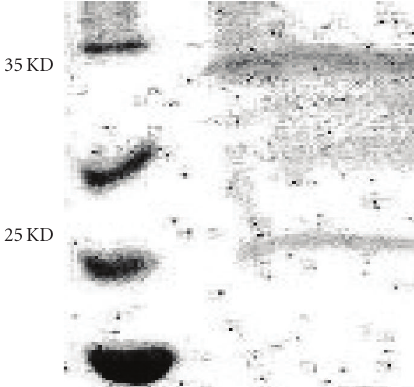
Figure 2: Burkholderia fungorum bacterial protein purified by anti-dsDNA antibodies a ffi nity column. The eluate from the column was examined by 12.5% SDS gel. The result shows that purified proteins contain two major bands, one is 35 KD bacterial protein and the other one is 25KD bacterial protein.